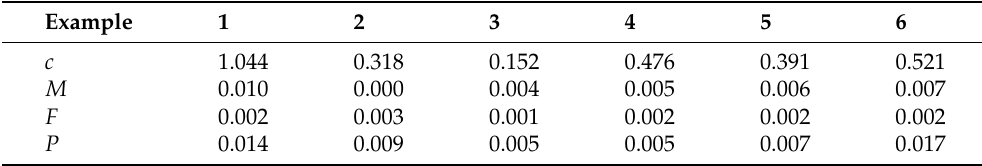
Table 3. Summary of evaluator losses (same examples as in Figure